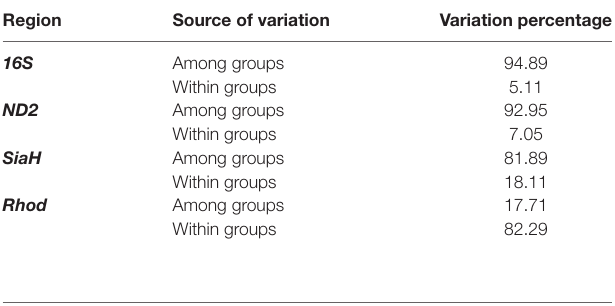
TABLE 1 | Analysis of molecular variance (AMOVA) for the mitochondrial and nuclear dataset of the P. nordestinus populations. The hierarchical tests were designed considering BAPS groups.